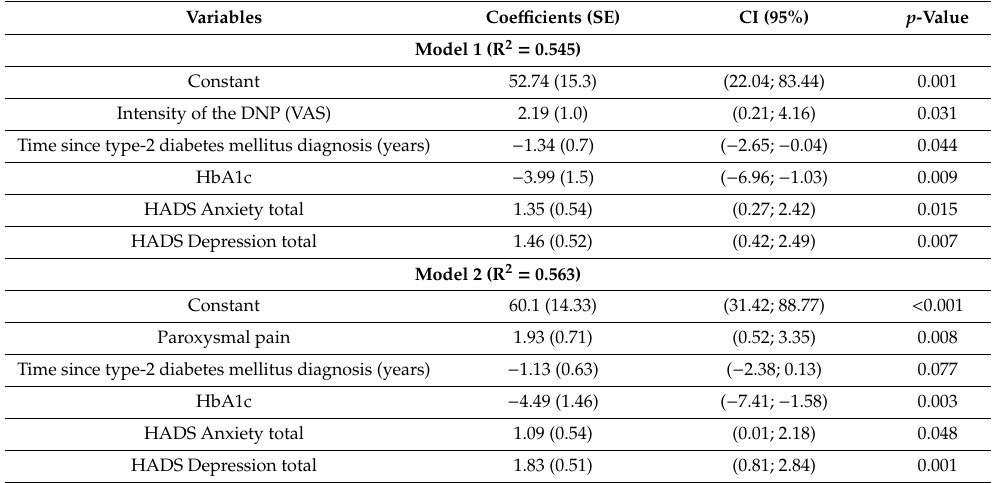
Table 5. Multiple linear regression models of the factors related with the sleep quality (Sleep Problem Index (I-9)) in DNP patients ( n =